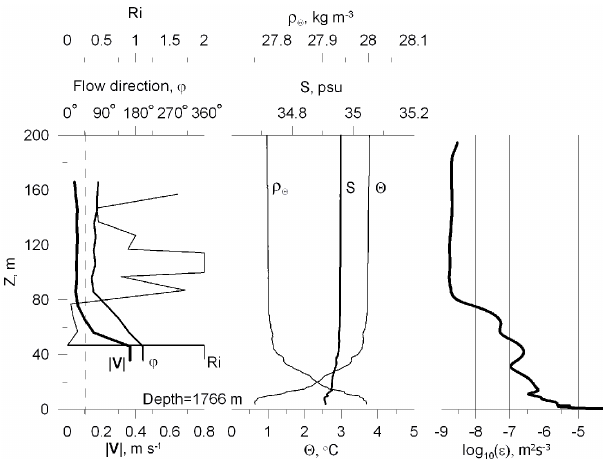
Fig. 6. The same as in Fig. 5, but for St. 123, displaying a relatively thin overflow plume with the bottom mixed layer almost